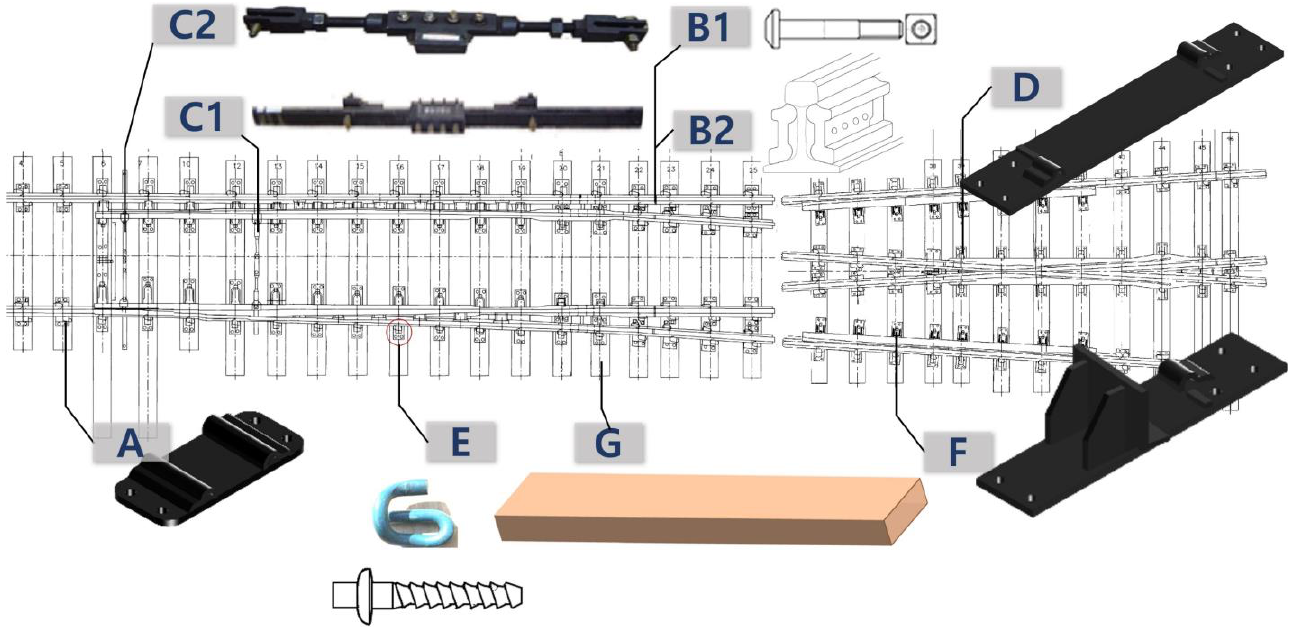
Figure 2. Turnout system components.